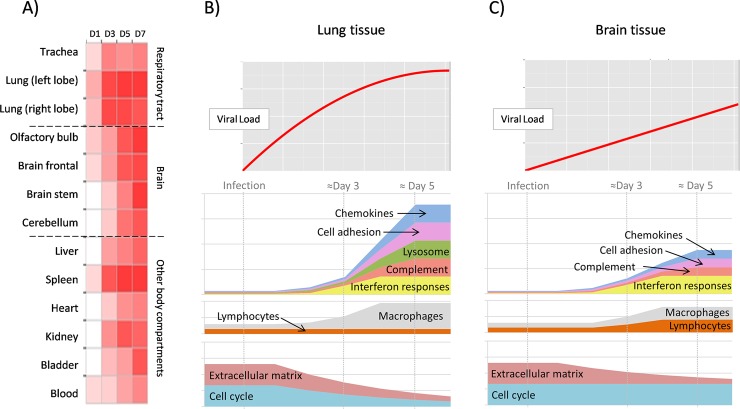
Sequential activation of host responses during Henipavirus infection.A) Upon infection of the upper and lower respiratory tract, the virus quickly spreads to a myriad of organs, including the central nervous system, liver, spleen, heart, kidney, bladder and blood (schematic representation of the data from HeV infection). B) In the lung tissue, the virus presents high growth rates and only after the inflammatory responses become fully active, at around day 4, the levels of virus stabilize but without significantly decreasing. Signaling and effector molecules of the innate immunity become expressed, innate immune cells migrate to the lung tissue, but, interestingly, gene expression data strongly suggest that lymphocytes are not migrating and expanding in the affected tissues. Additionally, the expression of genes related to the cell cycle, growth factors and growth factor signaling decline through the infectious process, possibly related to the degradation of the physiological functions of the lung tissue. C) In the brain tissue, the virus grows at a slower rate as compared to the lung tissue. The brain mounts a restricted immune response in accordance with the immunoprivileged status of this tissue that includes infiltration and/or local expansion of macrophages, and possibly of lymphocytes, but without leading to a noticeable alteration of the viral growth kinetics.